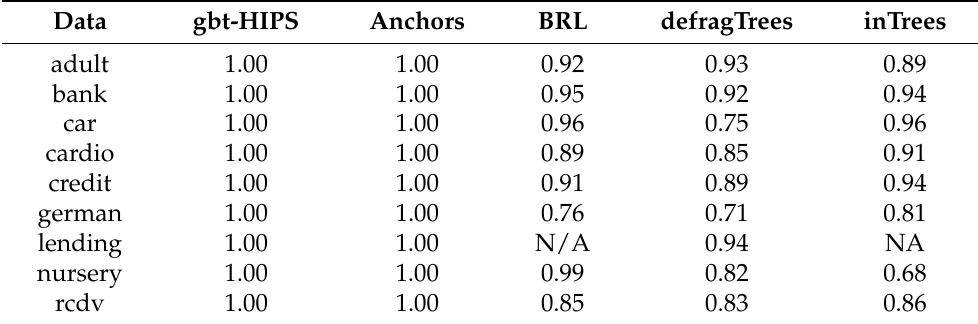
Table 4. Fidelity of Bayesian rule list (BRL), defragTrees and inTrees to the black box (gradient boosted tree (GBT))